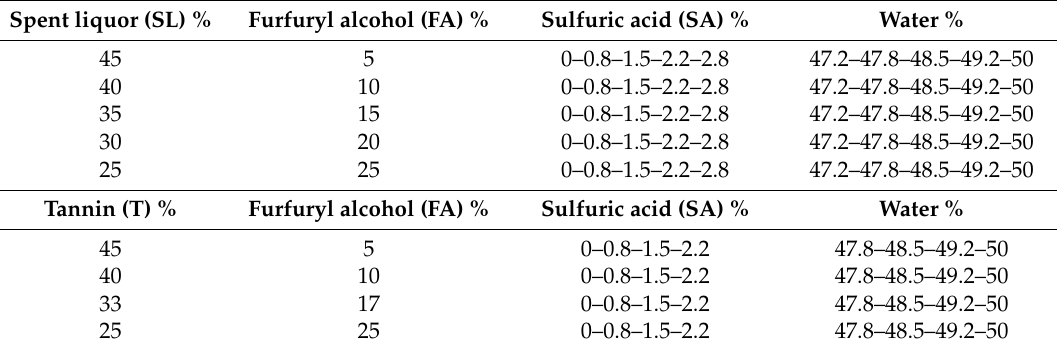
Table 1. Composition of spent-liquor/furfuryl alcohol (SL/FA) and tannin/furfuryl alcohol (T/FA)